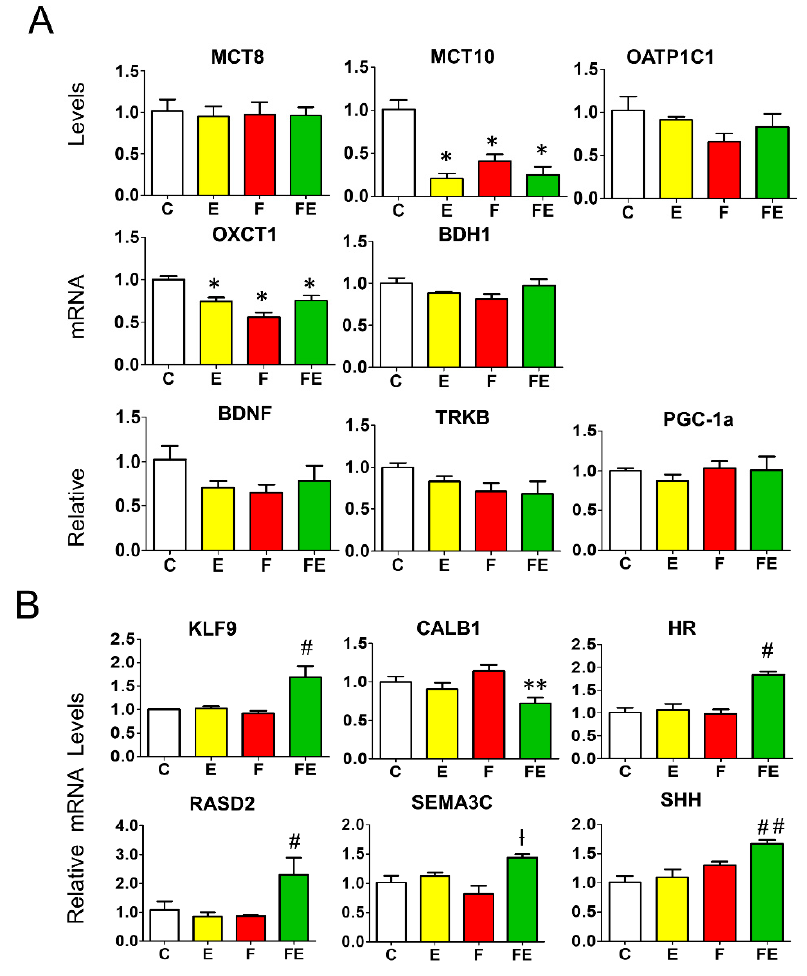
Figure 6. Expression of key genes involved in thyroid hormone and ketone action in the prefrontal cortex ( A ): Q-PCR analysis of genes involved in thyroid hormone transport, ketone transport and metabolism, and BDNF, TRKB and PGC-1 α . ( B ): Q-PCR analysis of T3-responsive genes in the pre- frontal cortex. ( A , B ): analysis was carried out using control rats or rats subjected to exercise, fasting, or fasting with exercise ( N = 4, n = 3). One way ANOVA was carried out followed by a Newman Keuls post-hoc test. * p < 0.05 vs. C, ** p < 0.05 vs F, † p < 0.05 vs. C and F, # p < 0.05 vs E, F, and C, ## p < 0.05 vs E and C. Abbreviations: N: biological replications, n: technical replications. Data are shown as means ± SEM.